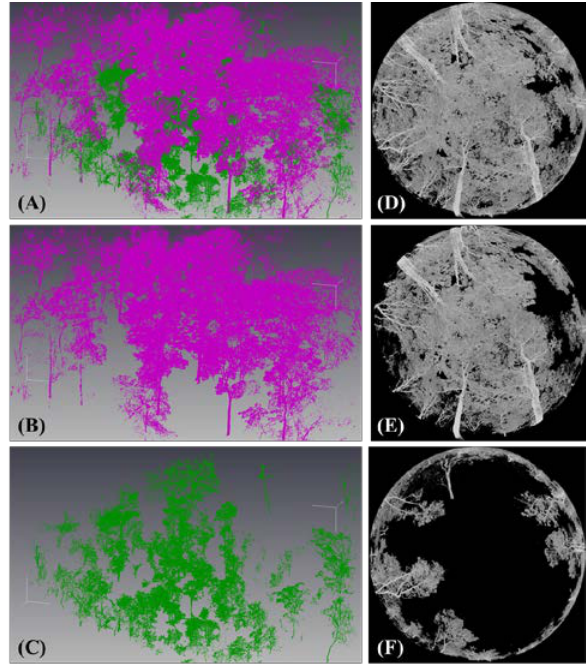
Figure 2. (A) The identified tree trunk (orange colour). (B) Figure 3. The classified TLS point and corresponding synthetic Dominant and non-dominant trees identified in the TLS point fisheye image for April 2014 data. (A) – (C) Canopy layer and data. (C) and (D) Classified TLS points where the tree trunk and understory layer were denoted as purple and green colours, leaves were correctly identified for canopy layer (purple colour) respectively. (D) The synthetic fisheye image of canopy layer and understory layer (green colour). and understory layer shown in (A). (E) The synthetic fisheye image of canopy layer shown in (B). (F) The synthetic fisheye image of understory layer shown in (C).